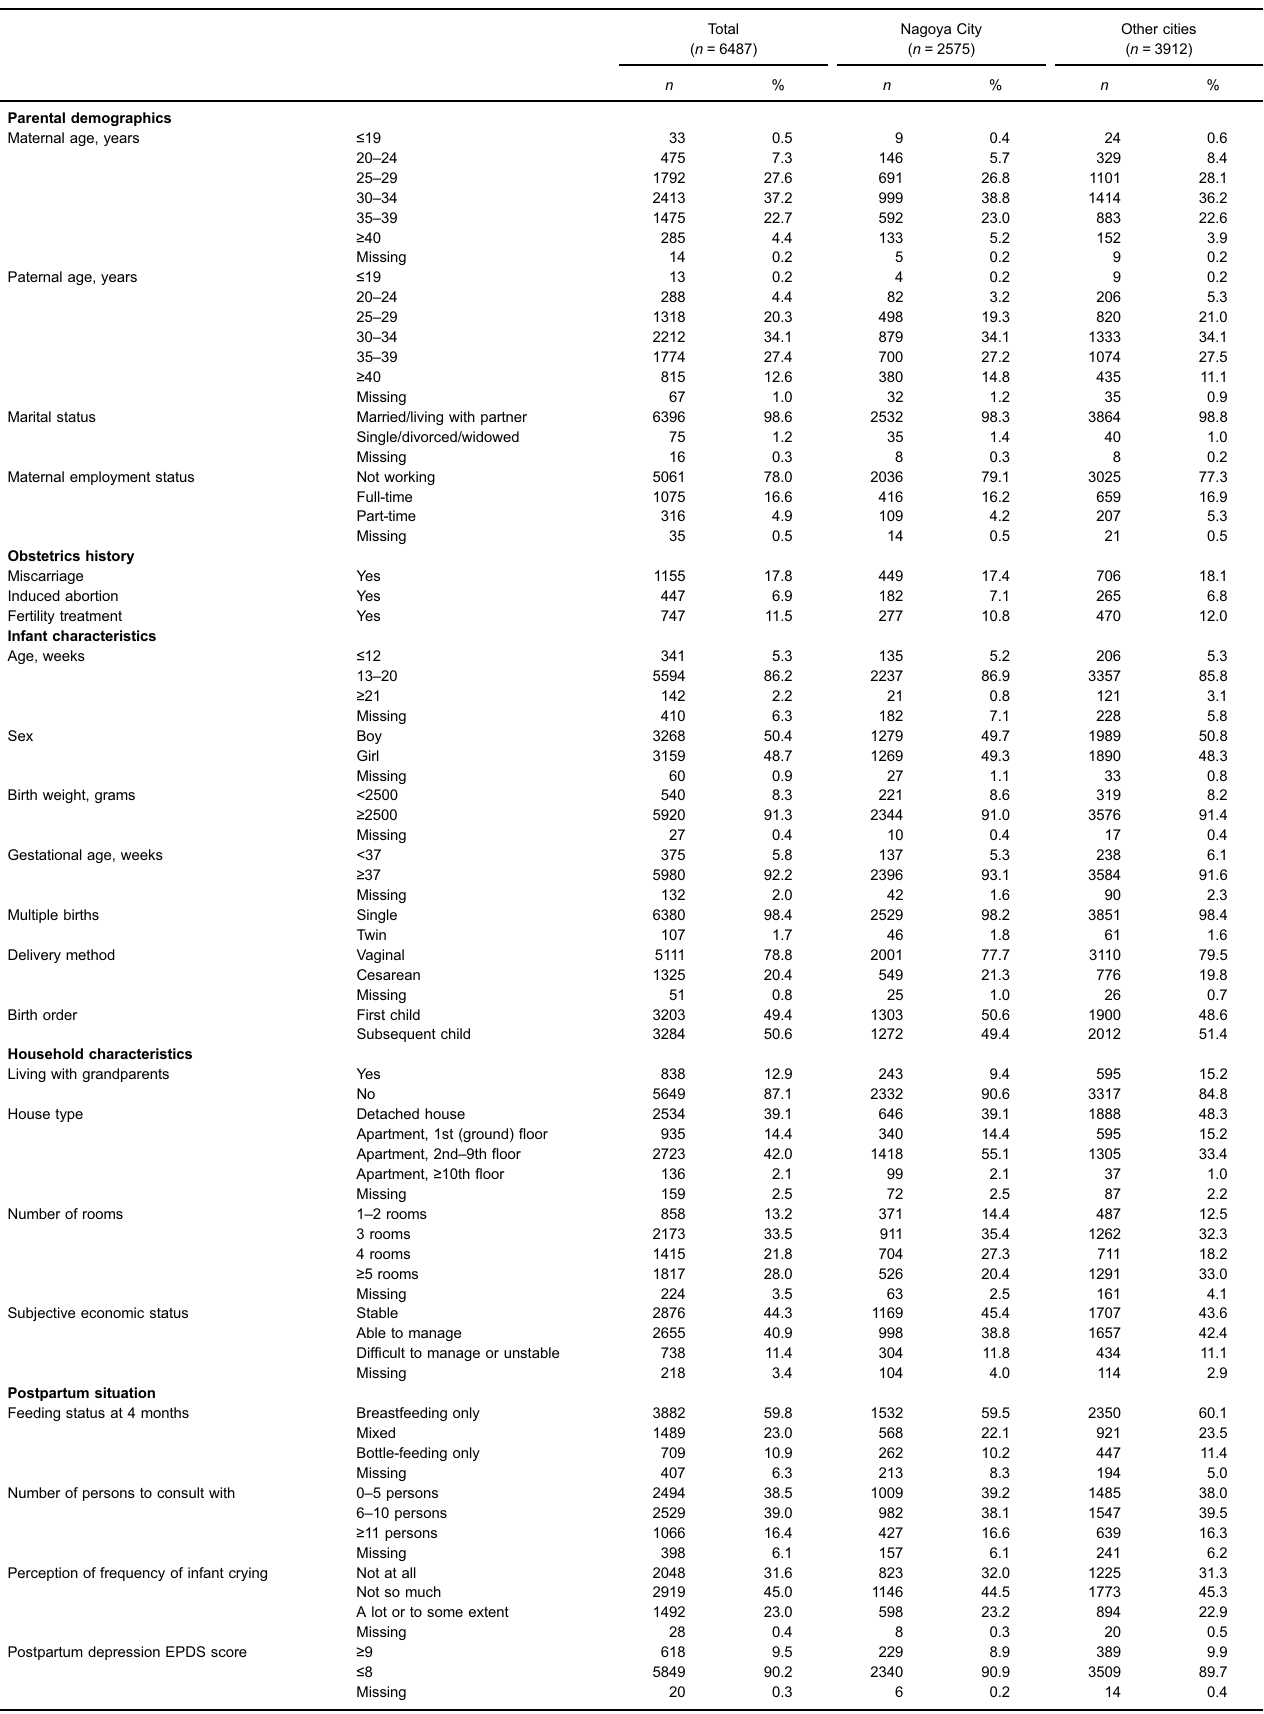
Table 1. Characteristics of